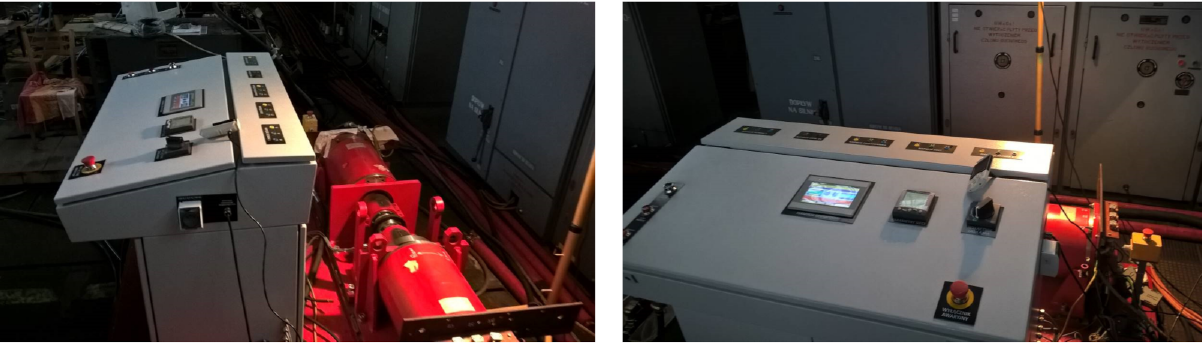
Figure 11. Stand for testing the drive